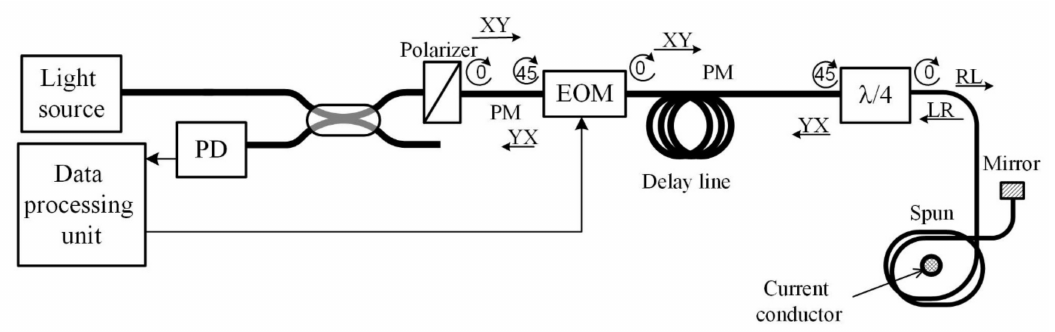
Figure 4. Optical scheme of the laboratory model of